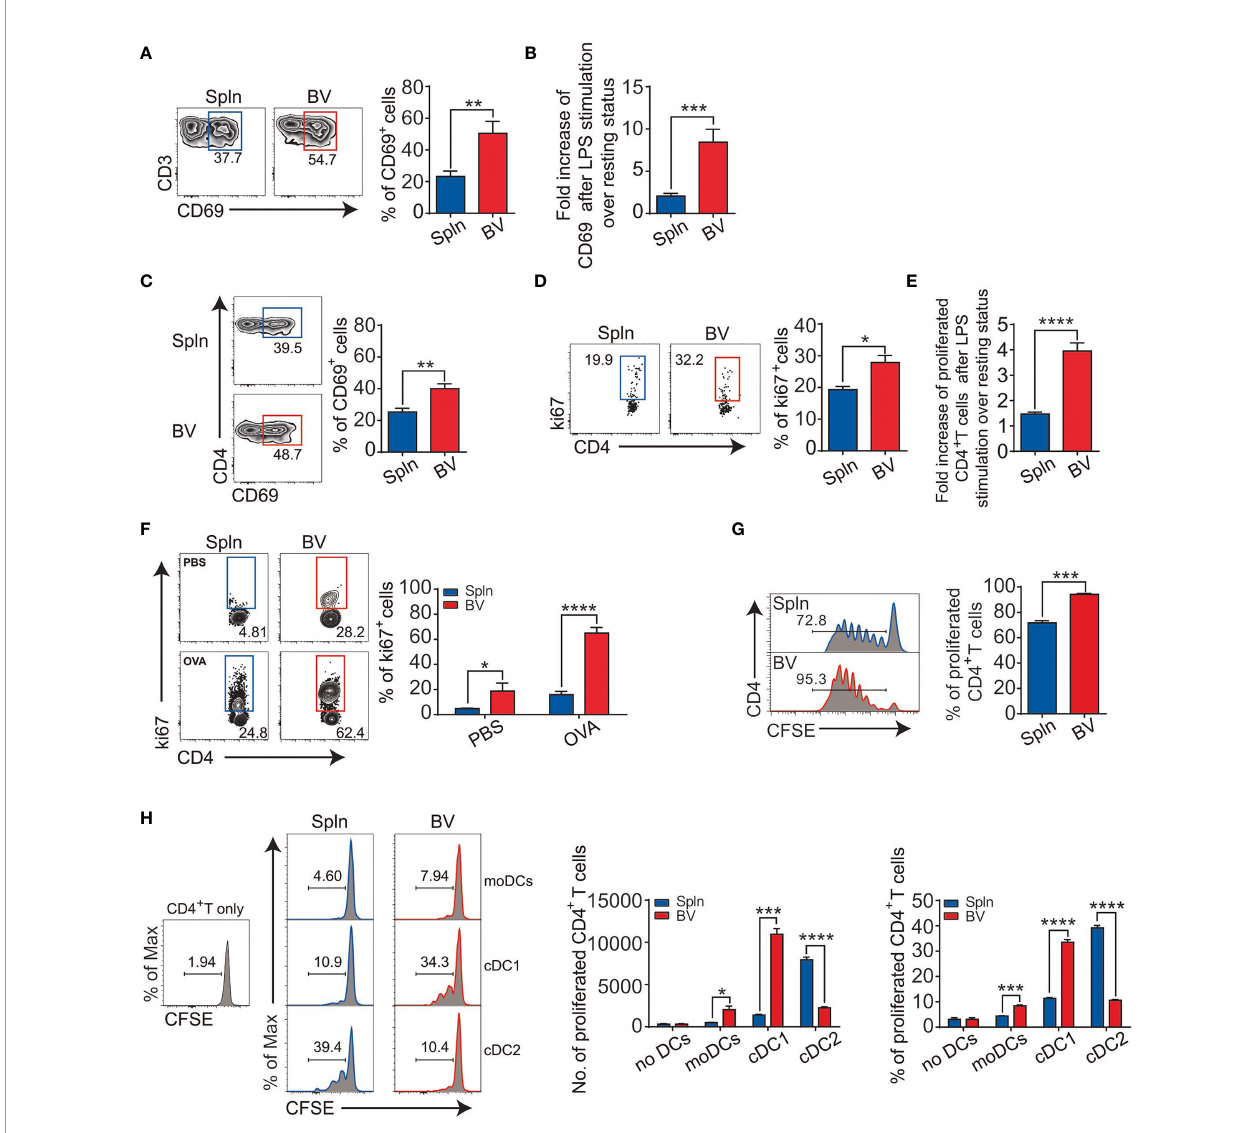
FIGURE 5 | Enhanced CD4 + T-cell activation and antigen presentation in vascular tissues during in fl ammation. Mice were i.v. injected with LPS before FACS analysis of the proportion (A) and fold increase (B) of CD69 in bulk T cells; percentage of CD69 (C) ; proliferated Ki67 + cells (D) ; and their fold increase (E) in CD4 + T-cell subset. Alternatively, OT-II mice were i.v. injected with 200 µg OVA or PBS with LPS for 72 h before FACS analysis of proliferated CD4 + T cells (F) . Puri fi ed CD4 + T cells from OT-II mice were labeled with CFSE and injected into CD45.1 mice before being immunized with OVA plus LPS for FACS analysis of proliferated CD4 + T cells (G) . Shown here are experiments with at least three biological replicates with error bars as mean ± SEM ( n = 3 – 8 mice). Sorted DCs from CD45.2 mice following LPS administration were cocultured with CFSE-labeled CD4 + T cells from OT-II mice in the presence of OVA for 3 days before the proliferation of CD4 + T cells were measured by FACS (H) . Shown here are one representative data from two independent experiments performed. * p < 0.05; ** p < 0.01; *** p < 0.001; **** p <